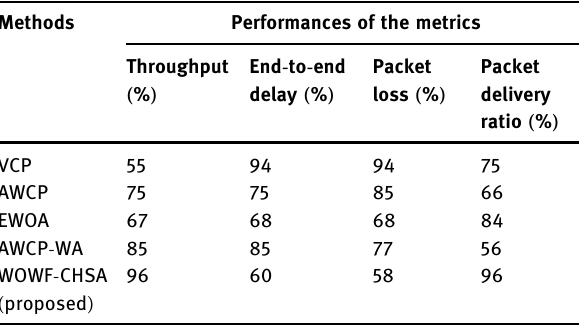
Table 3: Comparison of the proposed and existing methods